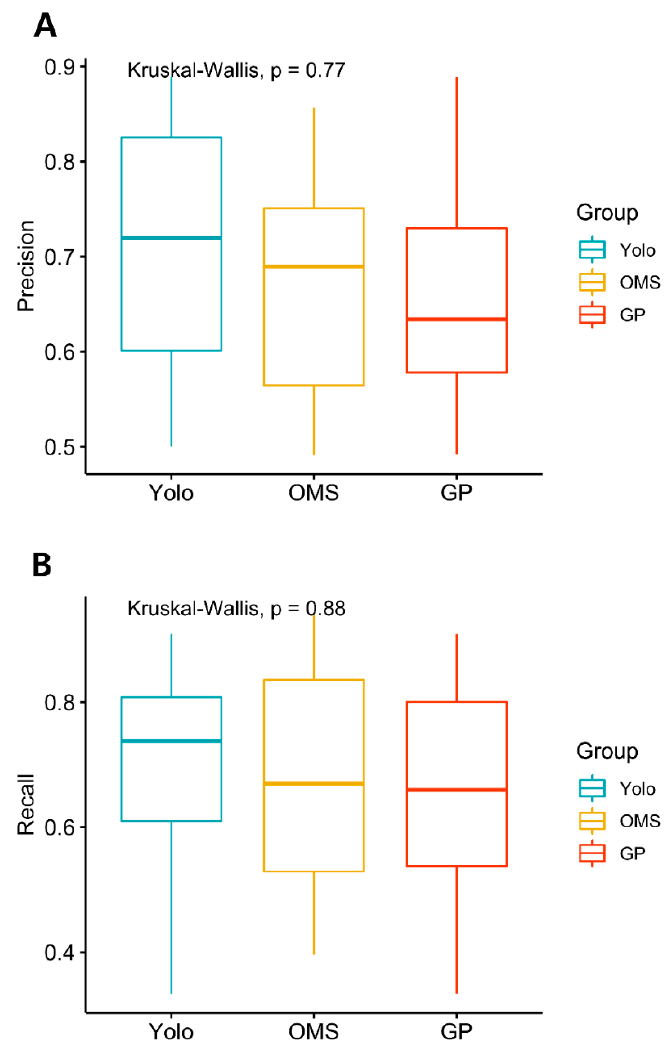
Figure 3. ( A ) Kruskal–Wallis test was performed to analyze the statistical significance of precision and recall among three groups (YOLO, OMS specialists, GP) A. Precision ( B ). Recall (p < 0.05). OMS: Oral and maxillofacial Surgery, GP: General practitioner.